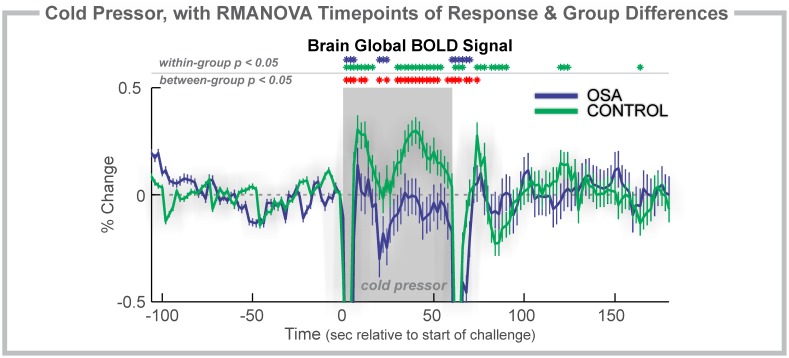
Cold pressor, 2 group.Time course of global BOLD signals during a cold pressor challenge (gray shaded rectangles). Change in BOLD signals, relative to baseline (group mean ± SE), with time-points of significant increase or decrease relative to baseline within-group, and time-points of between-group differences (RMANOVA, p<0.05).